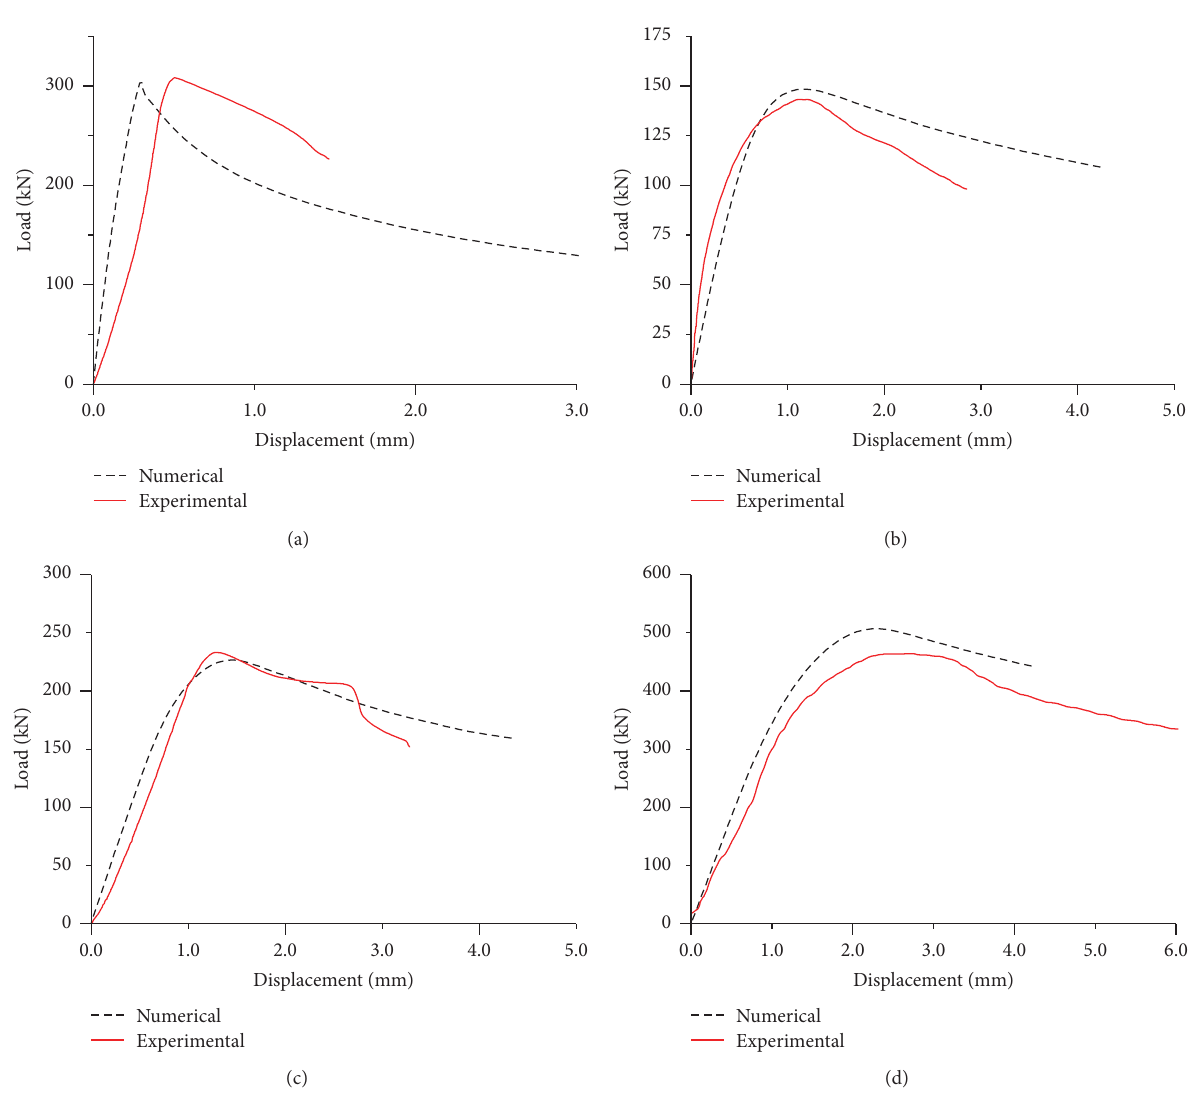
Figure 6: Experimental and numerical load-displacement curves for (a) C4NN, (b) E4NN, (c) E4AN, and (d) E4MN.